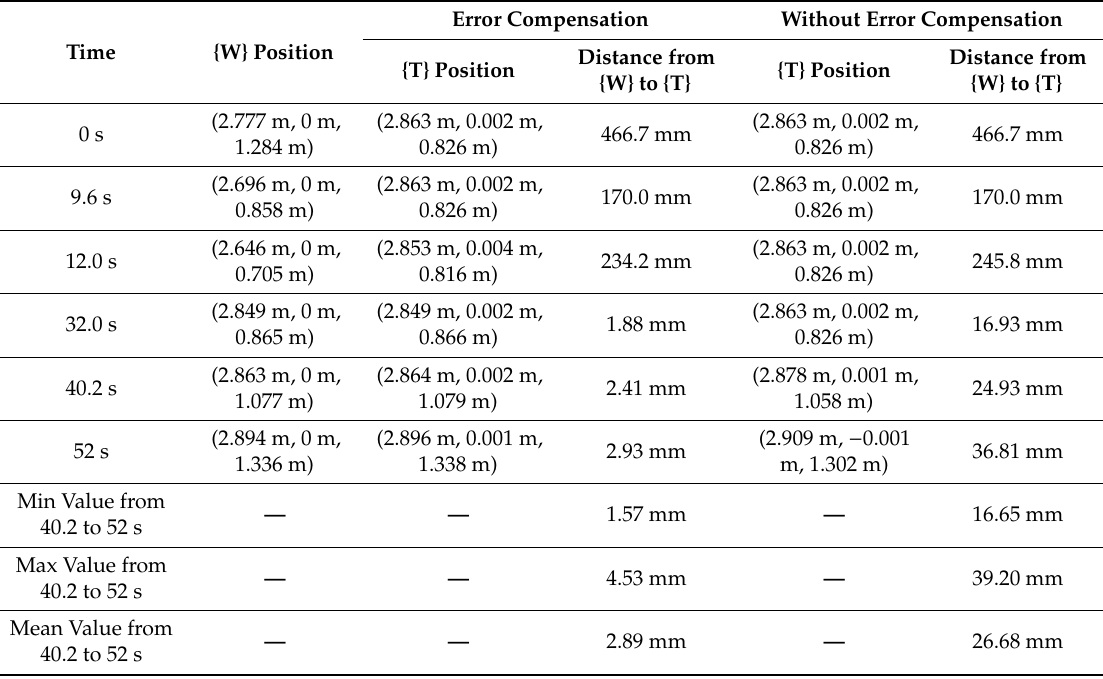
Table 2. Results of the contrast experiment of error